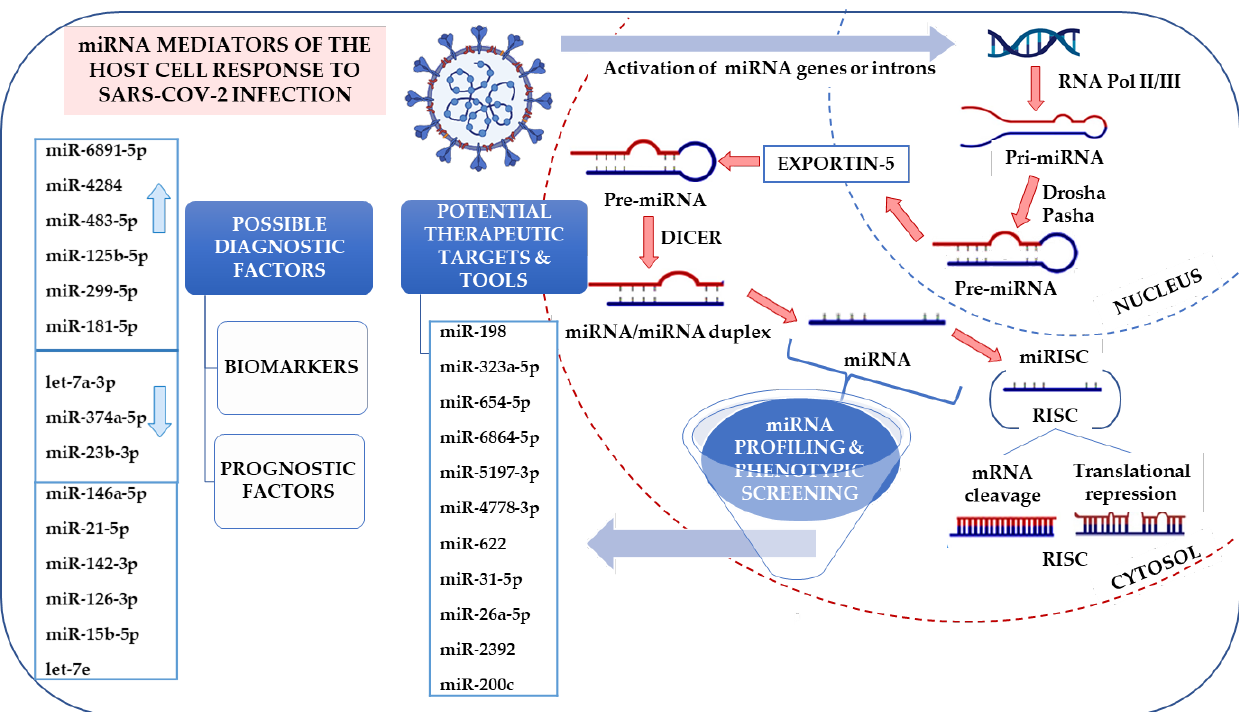
Figure 3. Schematic presentation of host’s miRNA formation mechanism, miRNA-mediated cellular regulation, and possible benefits of miRNA profiling in COVID-19-patients.